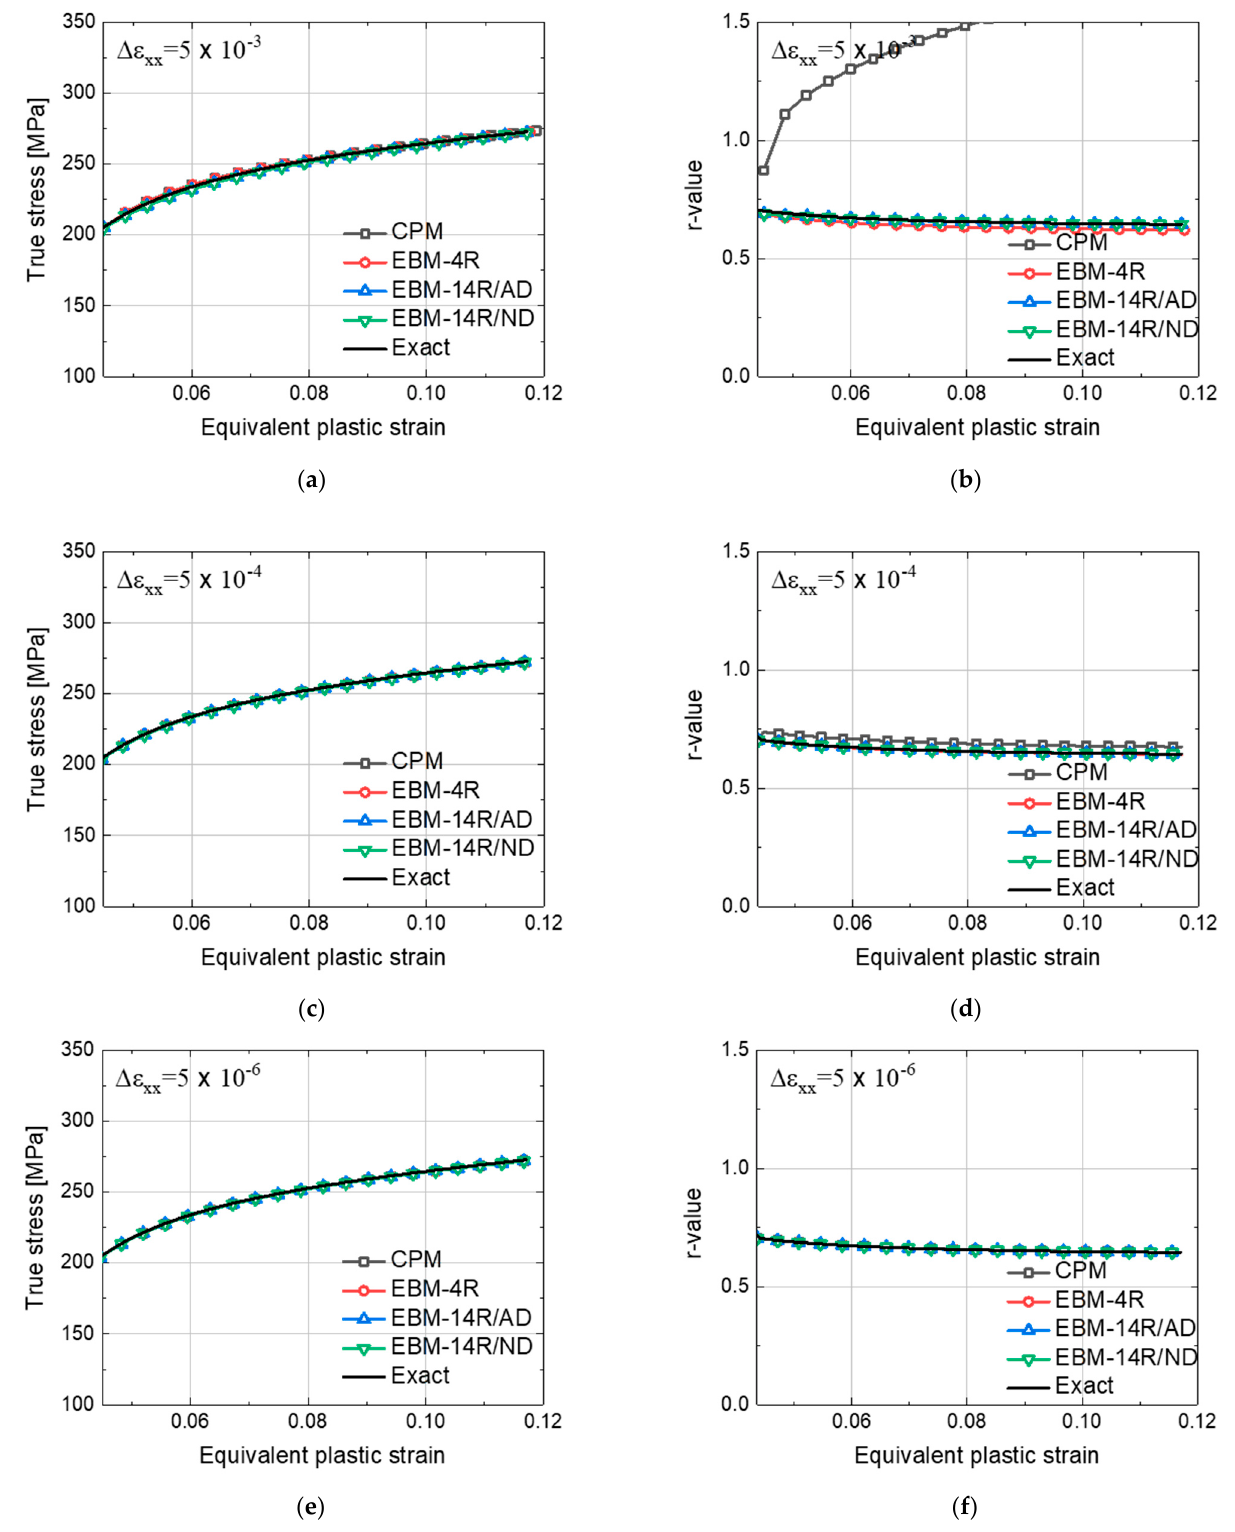
Figure 7. The evolution of the flow stresses and r − values of MAT 2 under C5T10R path for different stress integration algorithms with strain increments: ( a , b ) ∆ ε xx = 5 × 10 − 3 , ( c , d ) ∆ ε xx = 5 × 10 − 4 and ( e , f ) ∆ ε xx = 5 × 10 − 6 Table 3. Average relative errors in the flow curves and r − values of MAT 1 under C5T10R.